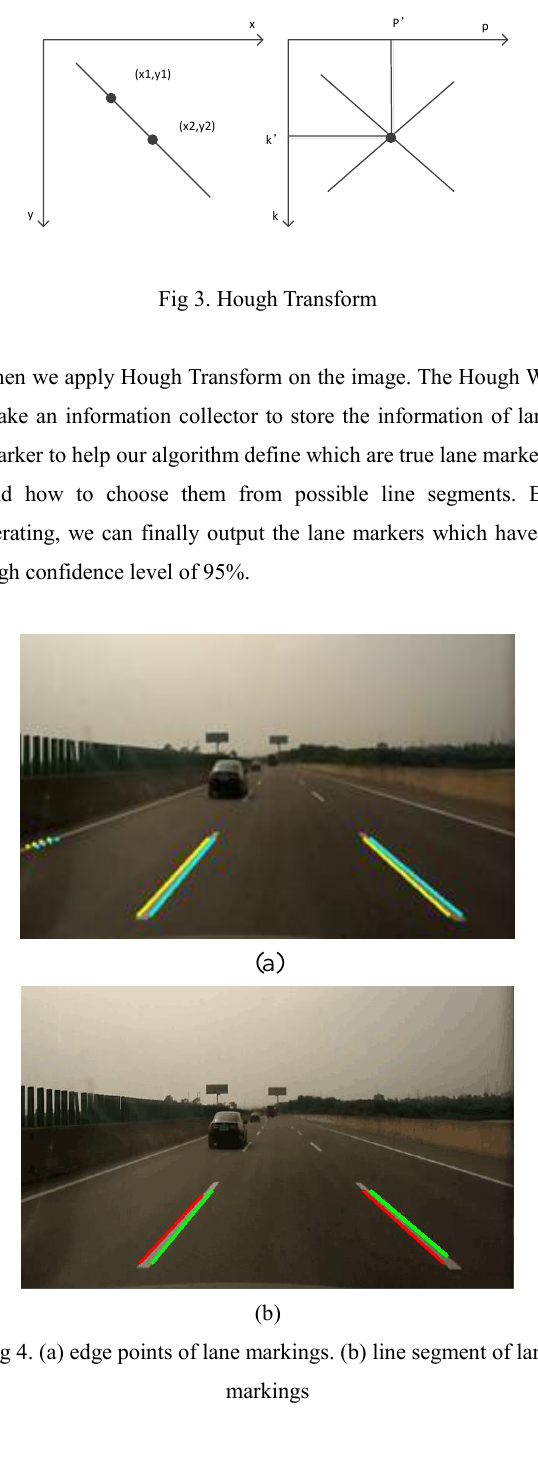
Fig2.The sliding window